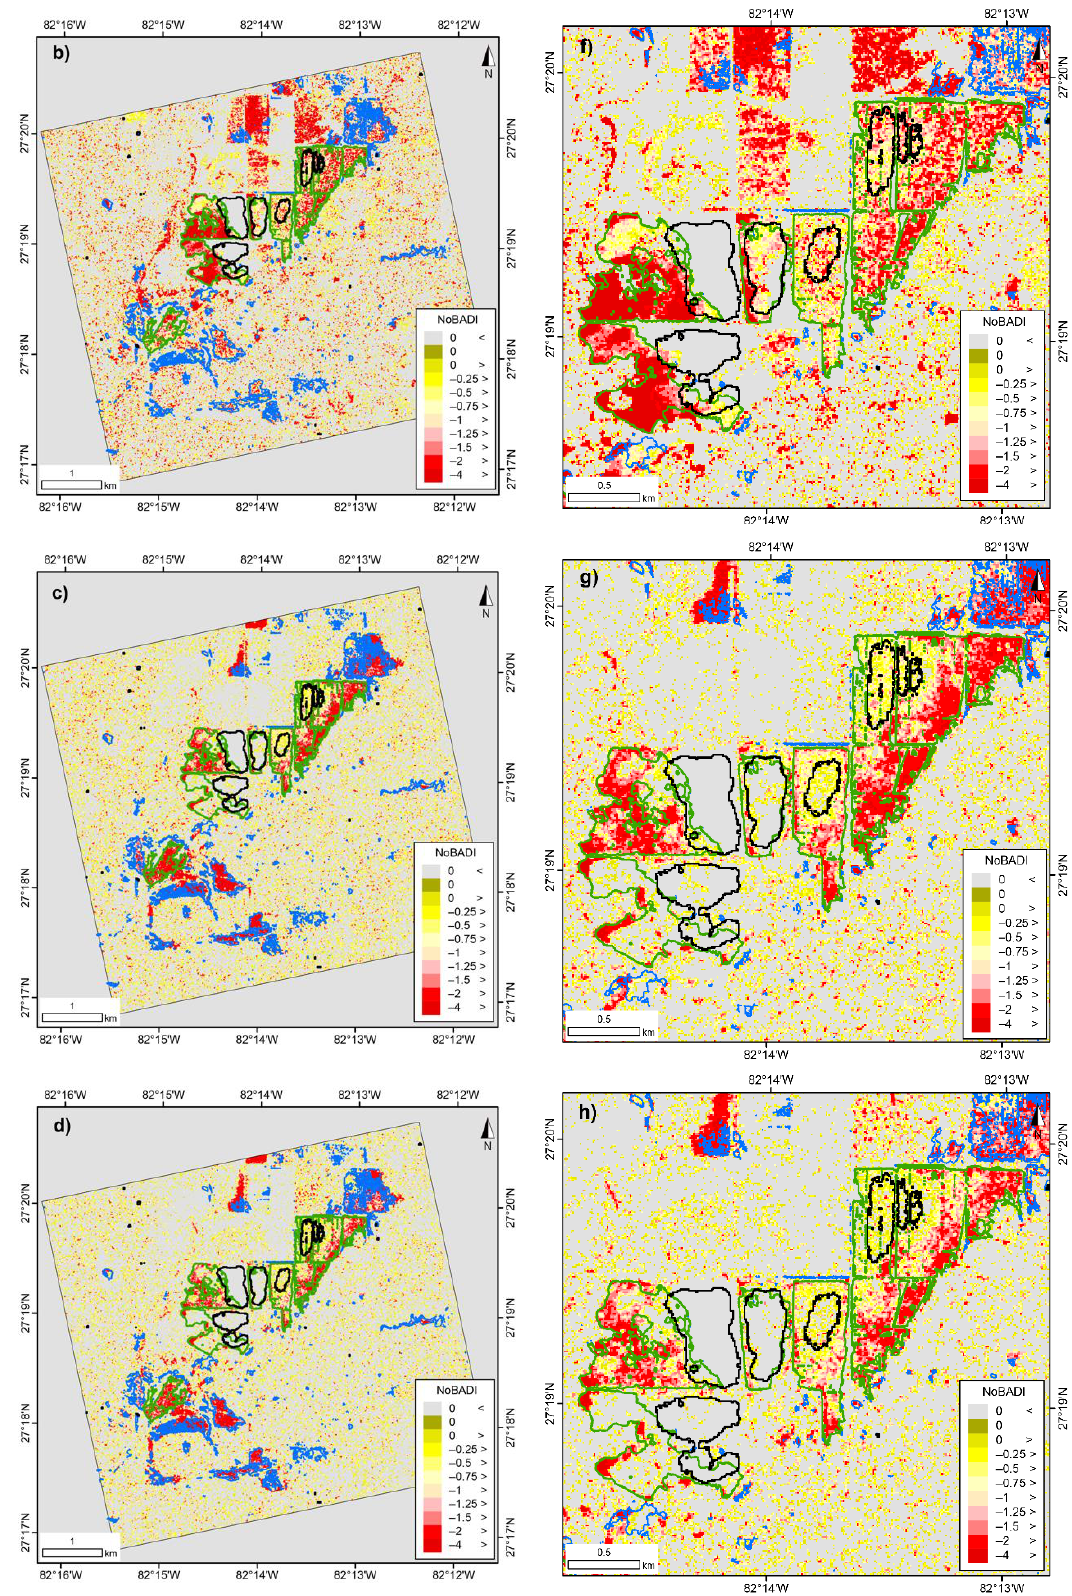
Figure 5. Spatial distribution of NoBADI calculated from PALSAR-2 ( a ) HH and ( b ) HV polarizations. Others are calculated by S1 ( c ) VV and ( d ) VH polarization. Optically identified water bodies are outlined in blue, in which ID-attached six portions are in green. Optically estimated frequent water extents (>20%) are outlined in black. Closed-up panels corresponding to the four results are in the same order ( e – h ).